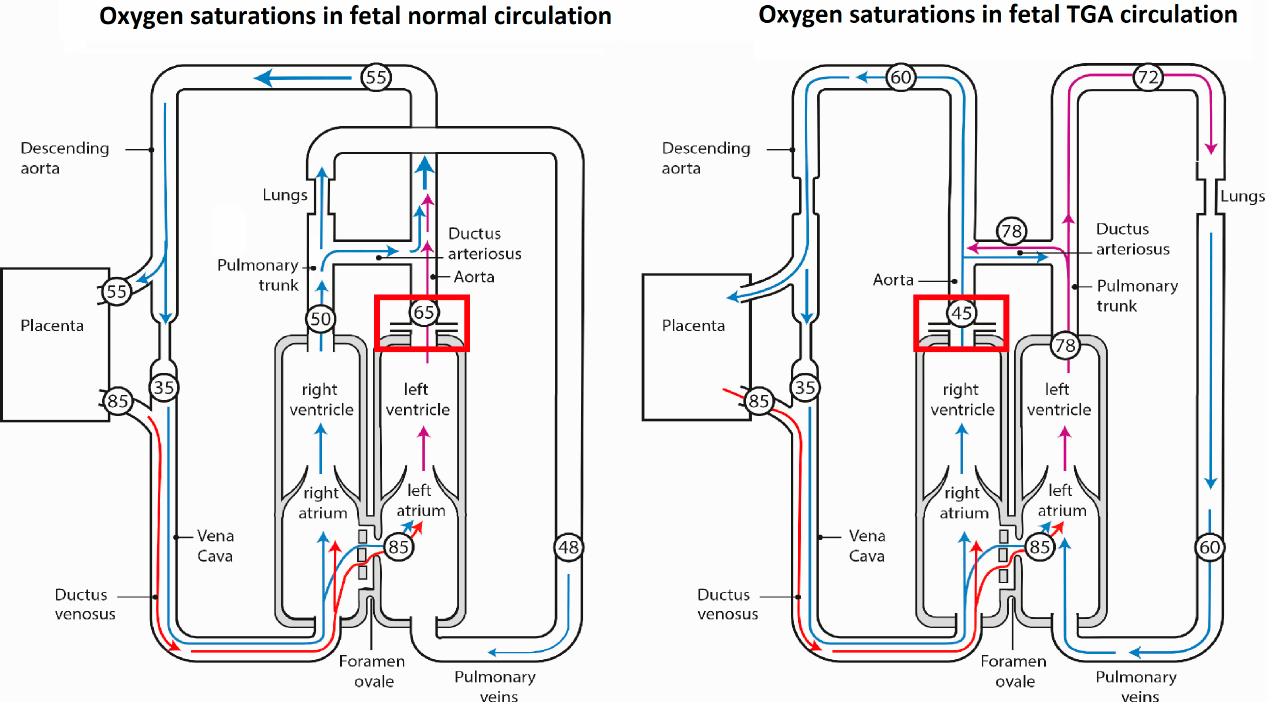
Figure 1. Normal circulation ( left panel ) and circulation in a fetus with TGA ( right panel ). The numbers indicate percentage of oxygen saturations in the cardiac chambers and great vessels, and are based on estimated values of umbilical blood flow and left and right ventricular output in the fetus [2]. In TGA, the subpulmonary left ventricle ejects blood into the pulmonary circulation so that blood perfusing the lungs and passing through the ductus arteriosus has a relatively high oxygen saturation. Blood entering the ascending aorta and coronary arteries has an oxygen saturation considerably lower than in the normal circulation (45% versus 65%, indicated by red squares). High oxygen saturations are illustrated by red arrows and lower oxygen saturations by purple and blue arrows. Abbreviations: TGA, transposition of the great arteries. The fi gure is modi fi ed and adapted from Rudolph et al. [2]. Copyright 2023 by Copyright Clearance Center.